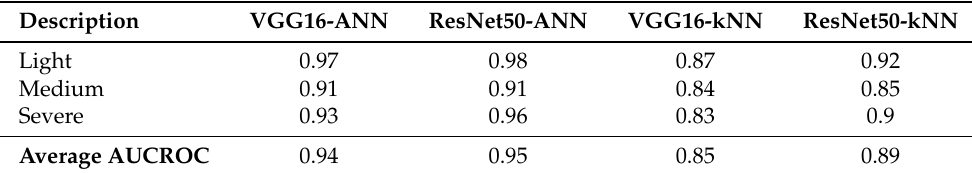
Table 4. Area under curve of ROC for each class based on RGB